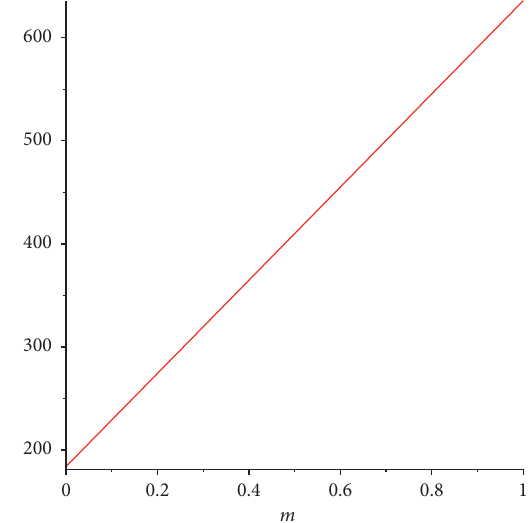
Figure 24: Plots of the first Gourava index for m − Bil